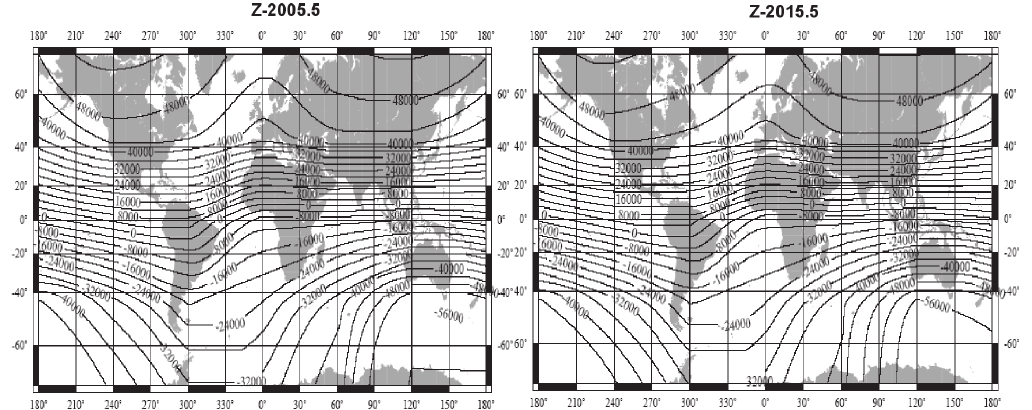
Fig. 11. Isolines of Y-Component predicted by the Neural Networks for two different